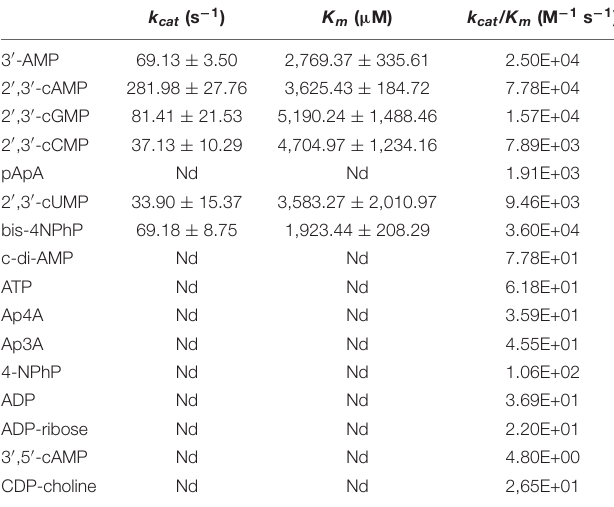
TABLE 3 | Kinetic parameters of